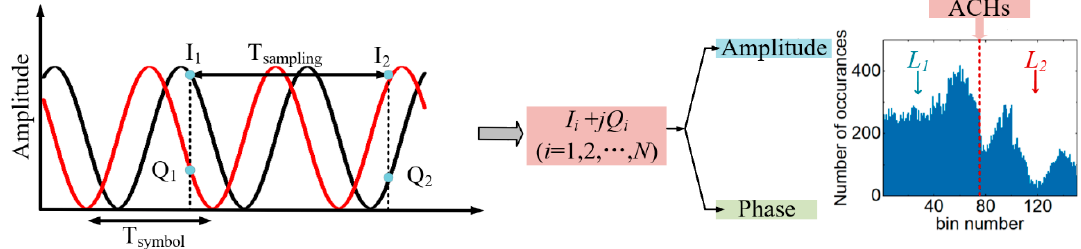
Figure 1. ACHs sampling principle of the PDM-S-16QAM optical network.